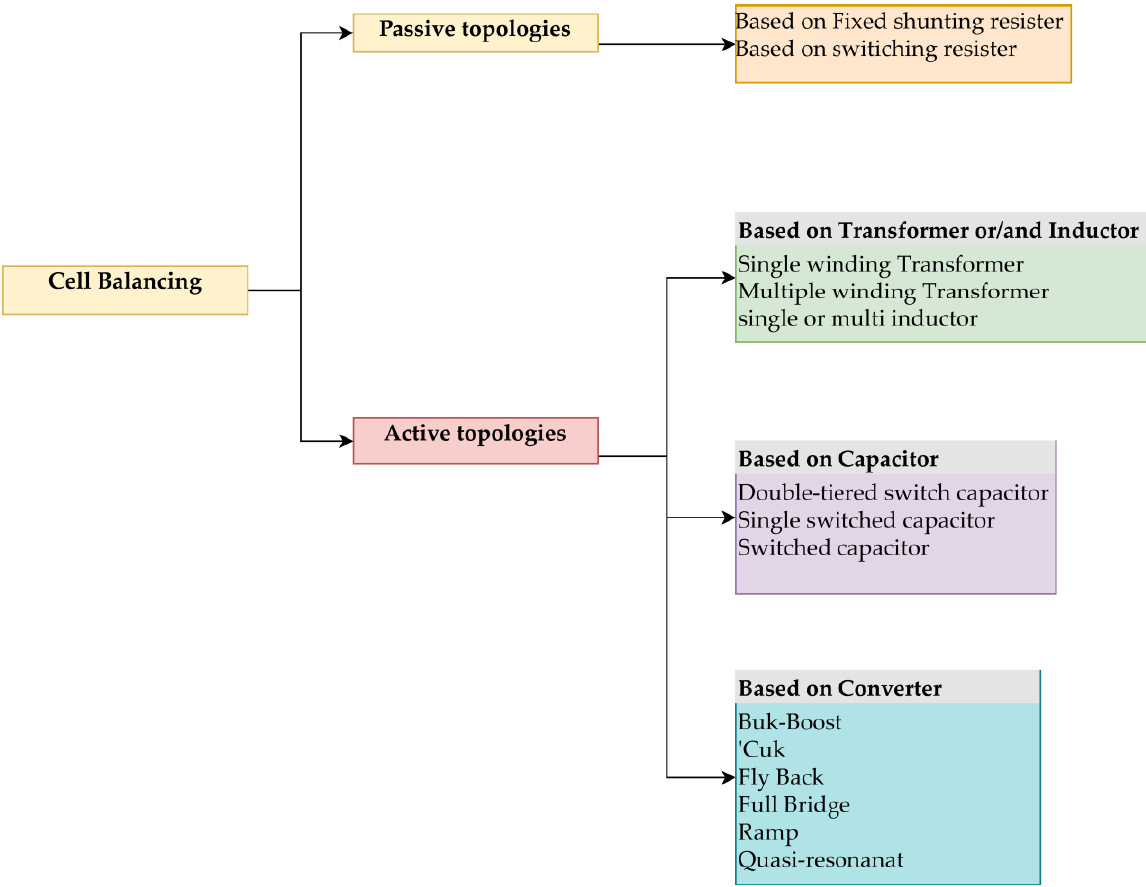
Figure 19. Cell-balancing technologies.